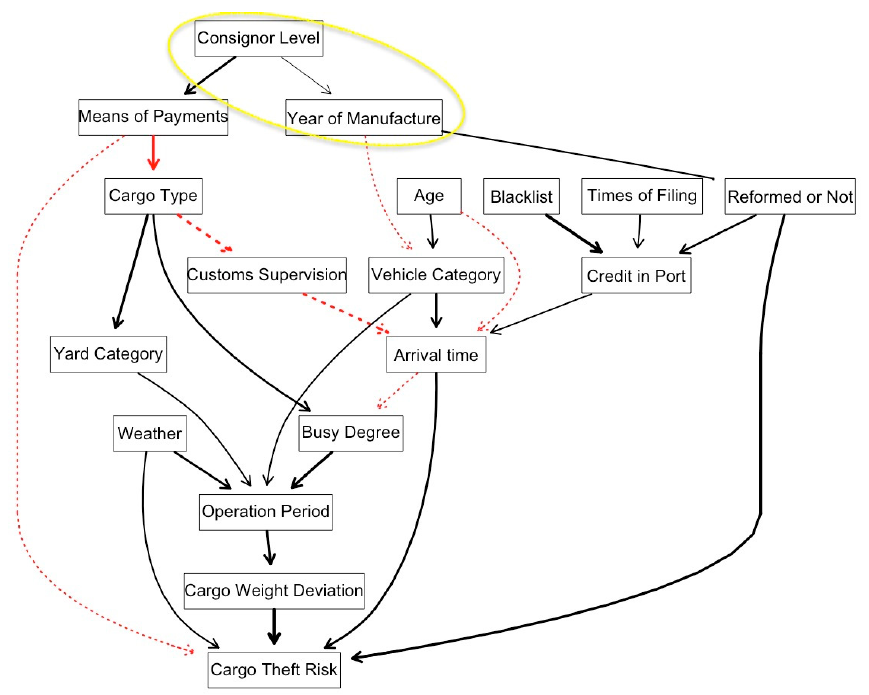
Figure A6. The Bayesian network structure derived using combinations of heuristic structure search algorithm with TABU and score function with BDe .